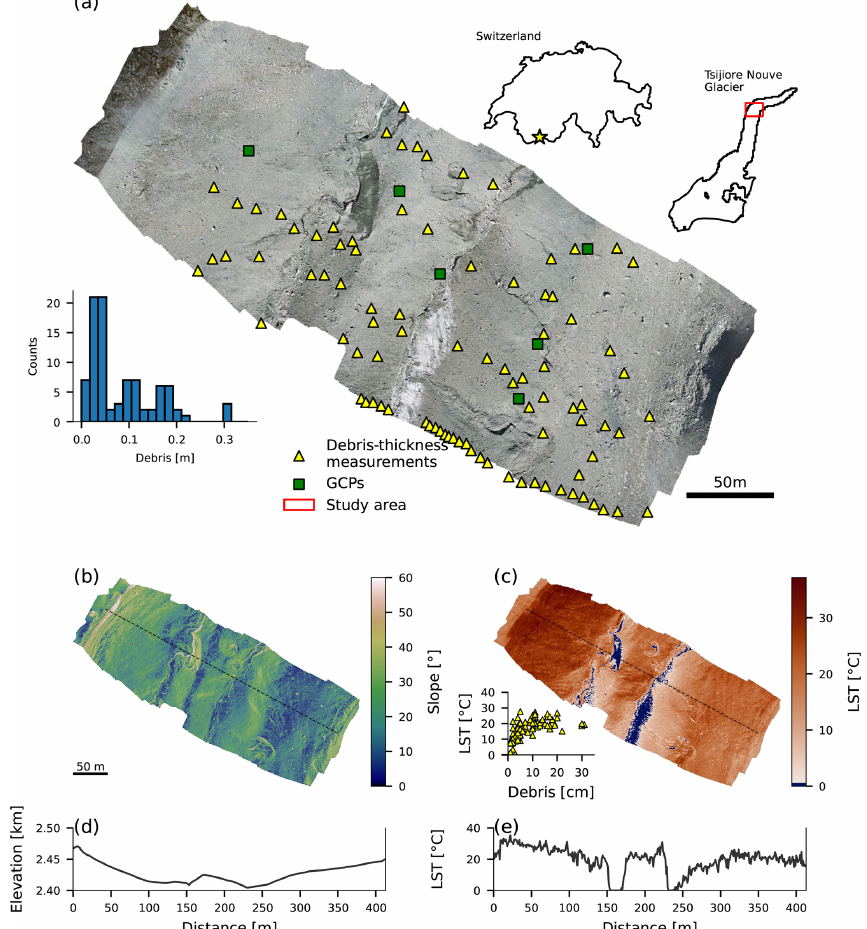
Figure 1. Overview of the study area on the Tsijiore Nouve Glacier, Switzerland. (a) Orthomosaic from optical unpiloted aerial vehicle (UAV) data obtained on 30 August 2019. Yellow triangles indicate locations of debris-thickness measurements, and green squares indicate ground control points (GCPs). The histogram shows the distribution of the debris thicknesses measured in the field. (b) Slope map obtained from UAV-derived digital elevation model (15cm resolution). (c) UAV-derived land surface temperature (LST) at 13:00 (UTC + 1). Blue areas depict LST < 0 . 5 ◦ C. The inset scatterplot shows in situ debris-thickness measurements versus LSTs. Black dashed lines in (b) and (c) indicate profiles shown in (d) (elevation) and (e)